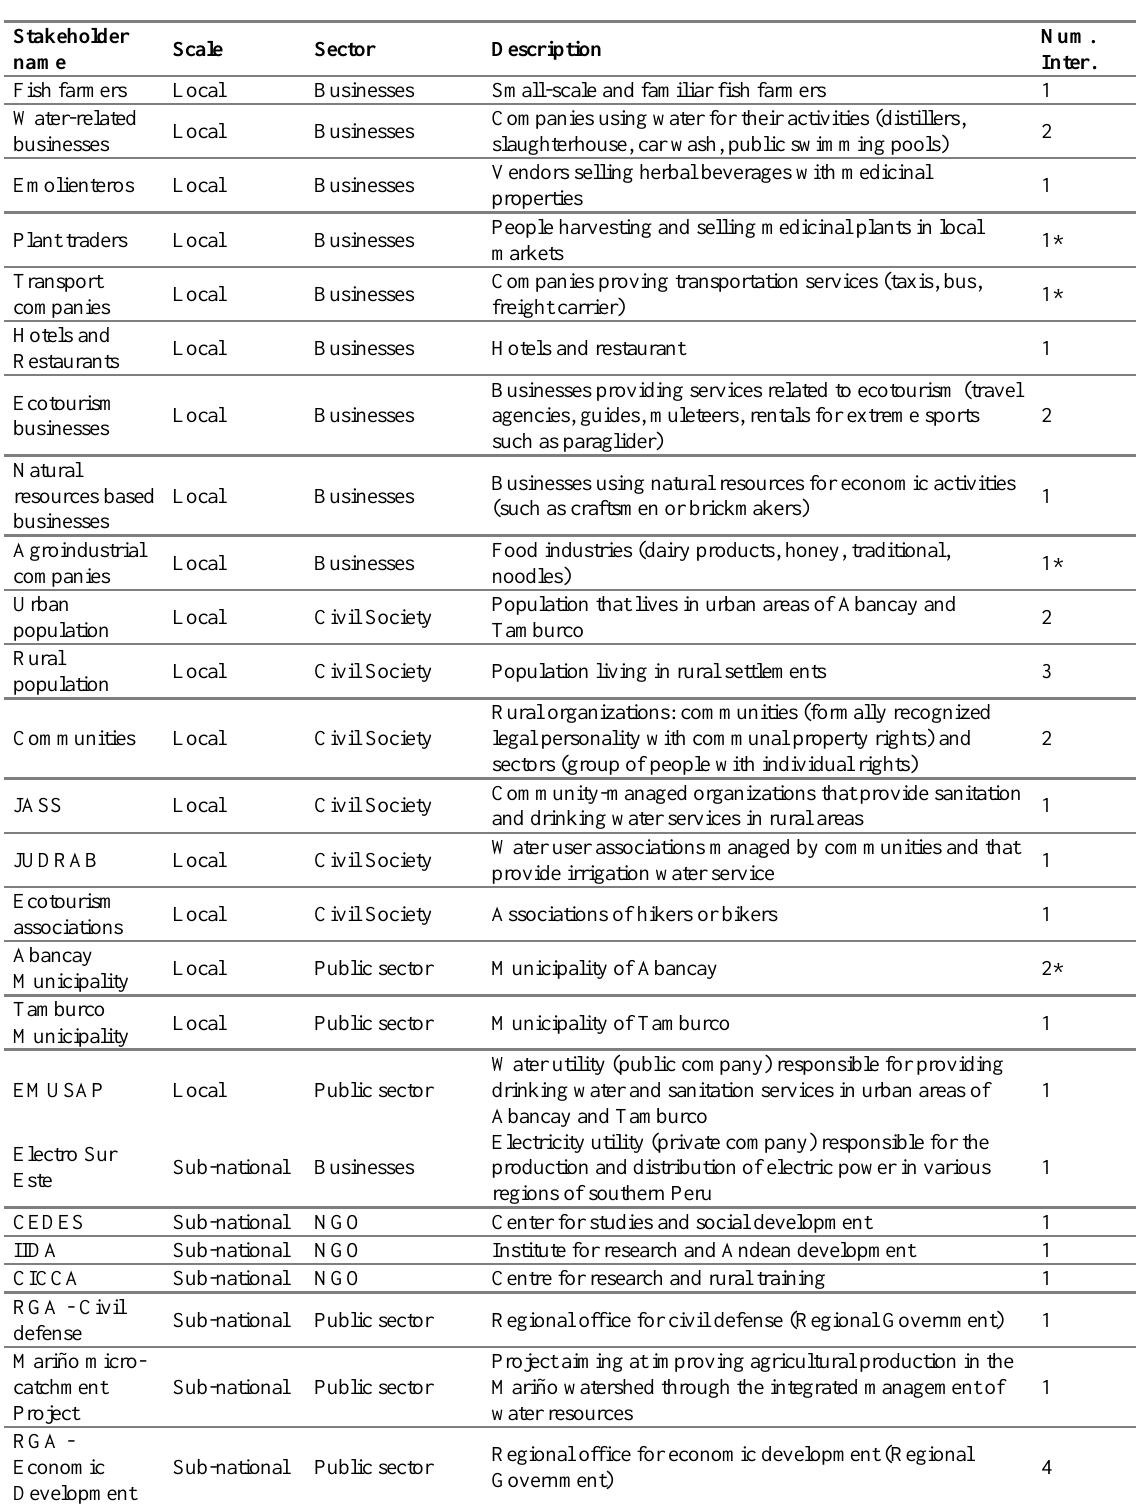
Table A2.1. Description and characteristics of the stakeholders selected for the analysis. Num. Int.: Number of interviews. (*) indicates the interviews that were conducted with multiple